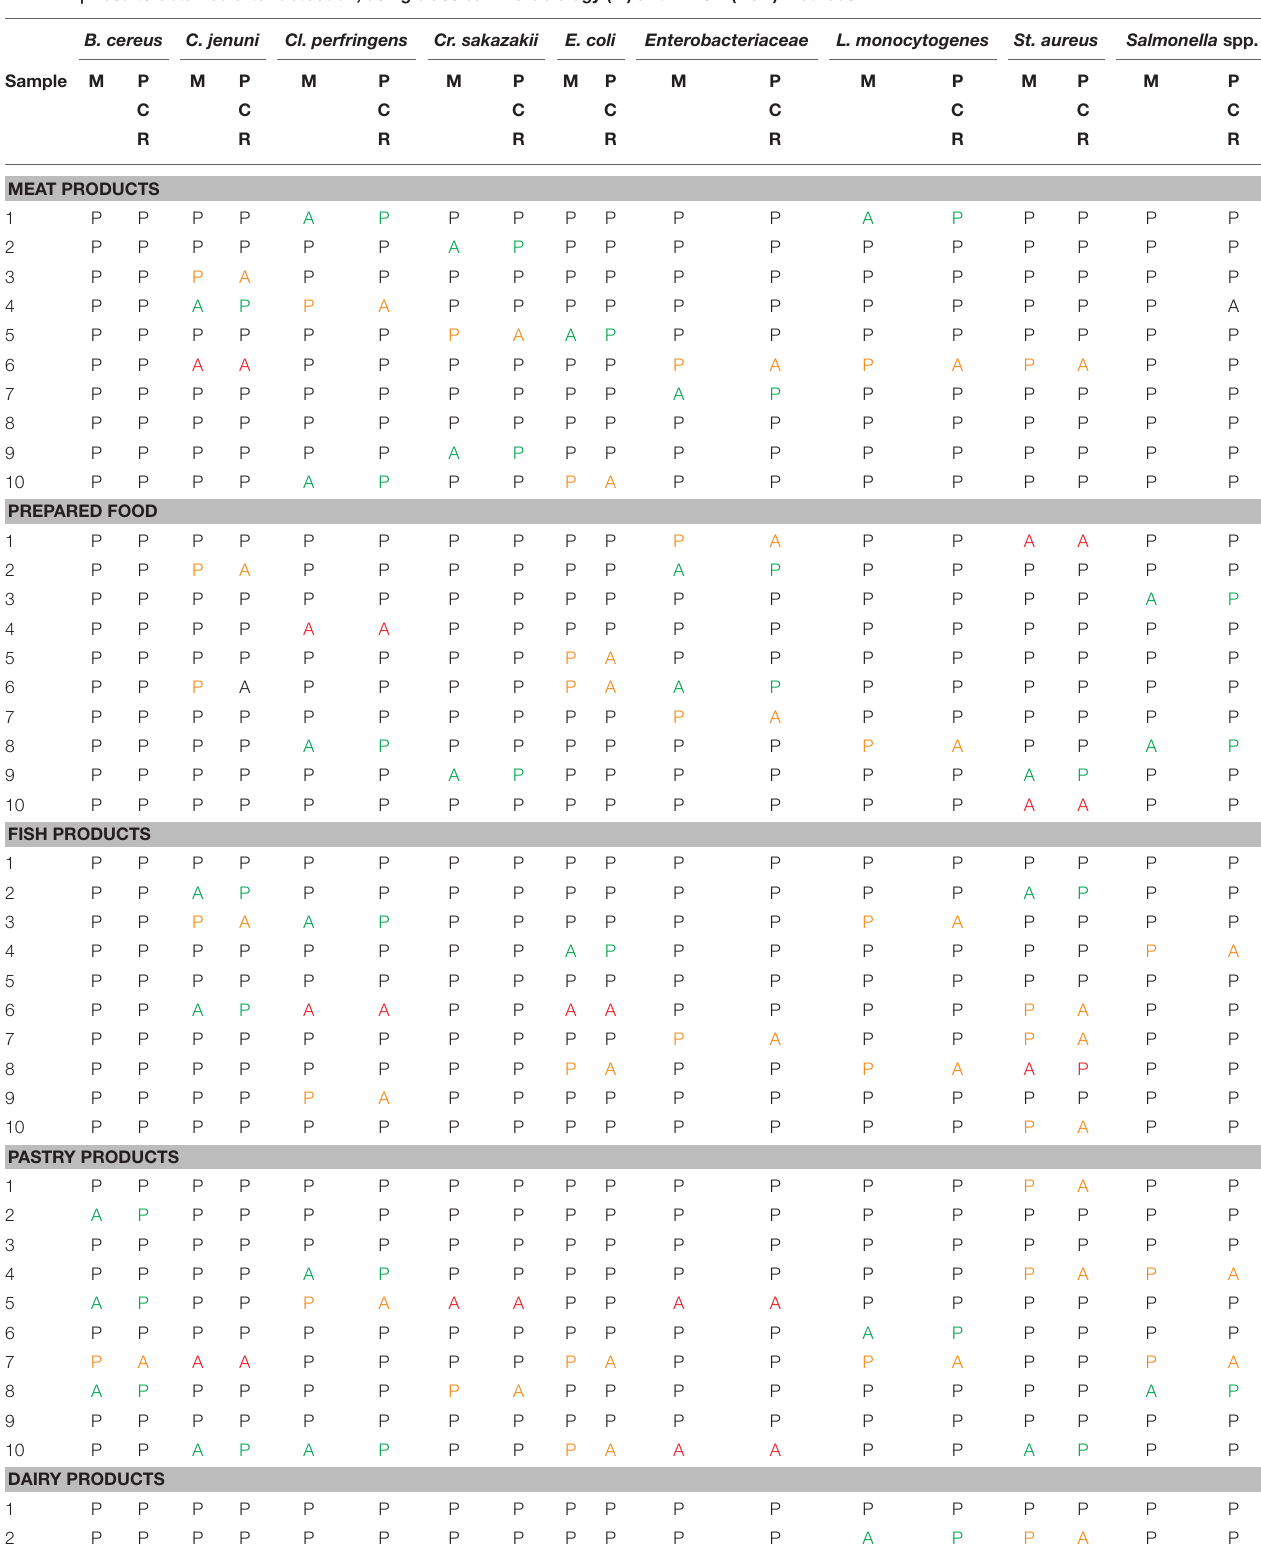
TABLE 4 | Results obtained after detection, using classical microbiology (M) and mPCR (PCR)